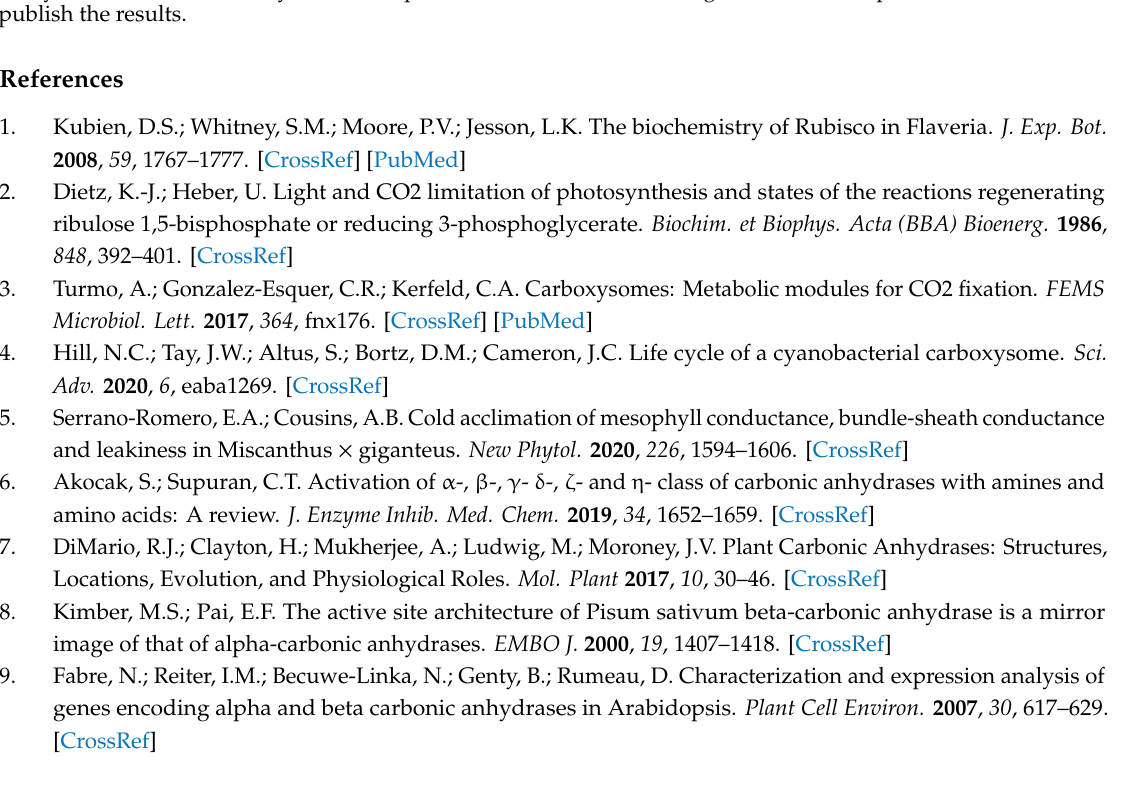
Figure S1: Redox-dependent activity and structure of α -CA from Sulfurihydrogenibium azorense , Figure S2: Cysteine ring of the dimeric β CA1 structure, Figure S3: Molecular dimension of the β CA1, Figure S4: Western Blot of redox-titrated β CA1, Figure S5: Influence of TRX-f1 and NTRC on the conformation of β CA1, Figure S6: Characterization of β ca1 knock out lines (SALK_106570C and SALK_131447), Table S1: Primers used in this study for